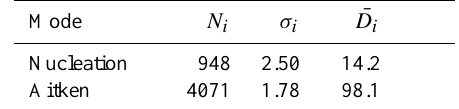
Table 2. Parameters of the three log-normal fits shown in Fig. 9. The parameters N i , σ i and ¯ D i refer to mode num- ber concentration, mean geometric diameter, and geometric stan- dard deviation, respectively, for a given aerosol diameter D as N i √